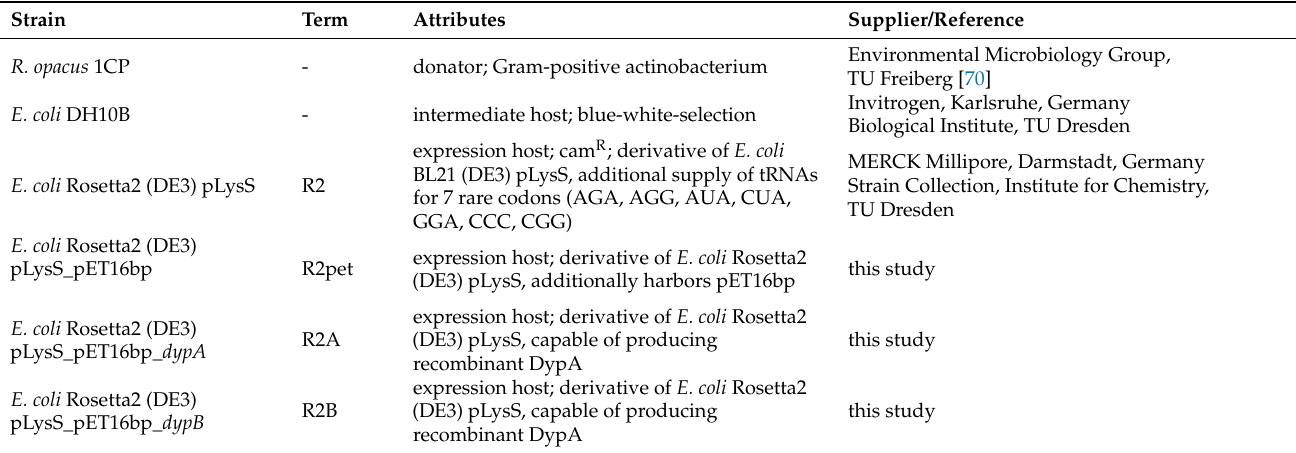
Table A1. Donor, intermediate and expression hosts.